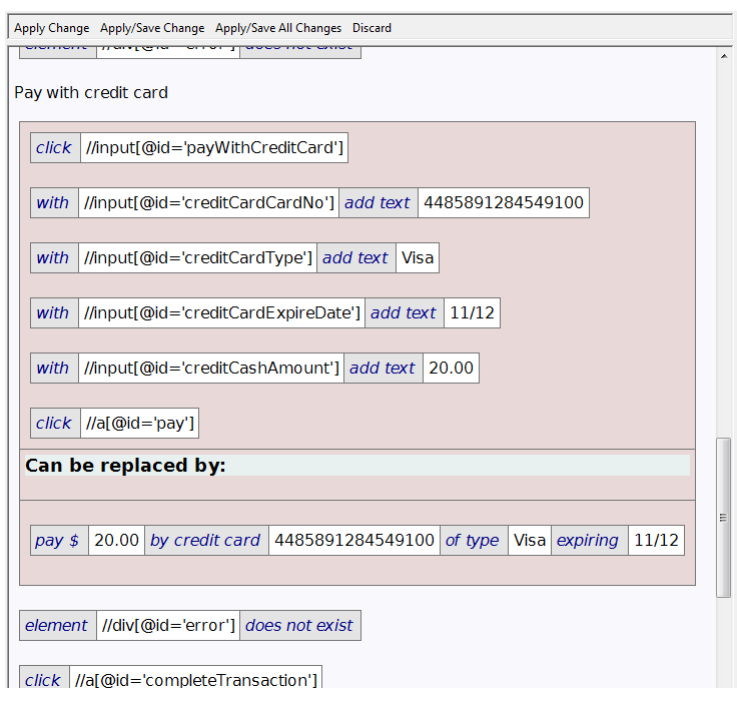
Figure 6. A potential